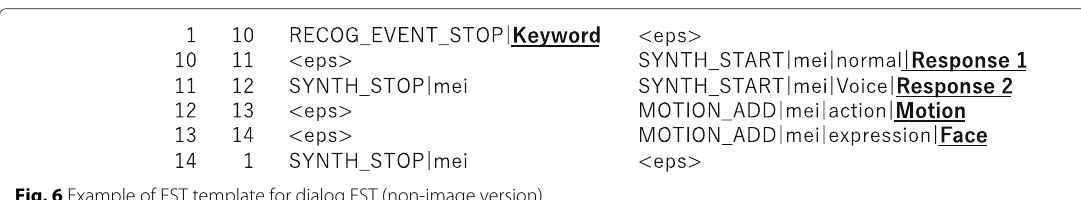
Fig. 6 Example of FST template for dialog FST (non-image